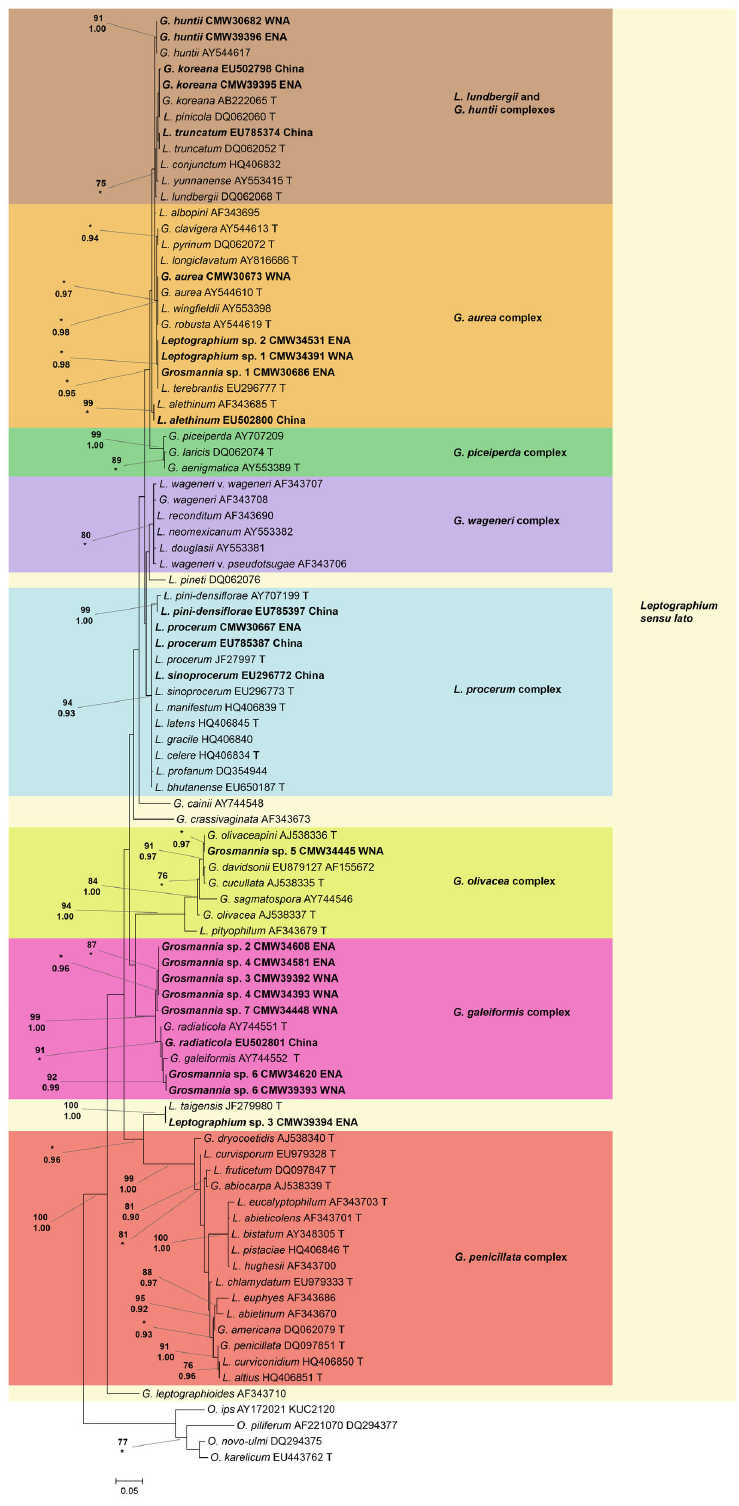
Figure 3. Phylogram of Leptographium sensu lato based on ITS2-LSU. ML phylogram of 87 ophiostomatalean fungi in the genus Leptographium sensu lato , and four in the genus Ophiostoma sensu lato as an outgroup, based on ITS2-LSU. Each strain is indicated following the same criteria as Figure 2. Statistical support for the nodes is shown in the same format as Figure 2. doi: 10.1371/journal.pone.0078126.g003 PLOS ONE |